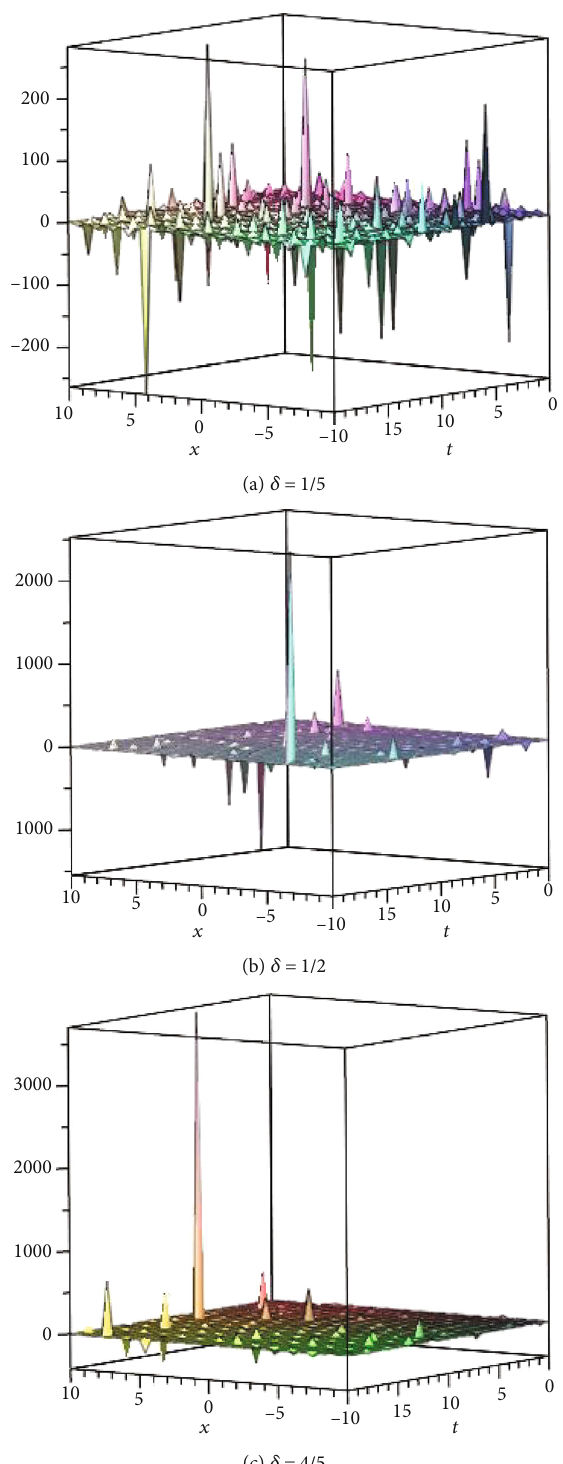
, x Þ in Equation (41) for di ff erential values of the fractional parameter δ Figure 7: The positive real part of u 3 1 ð t